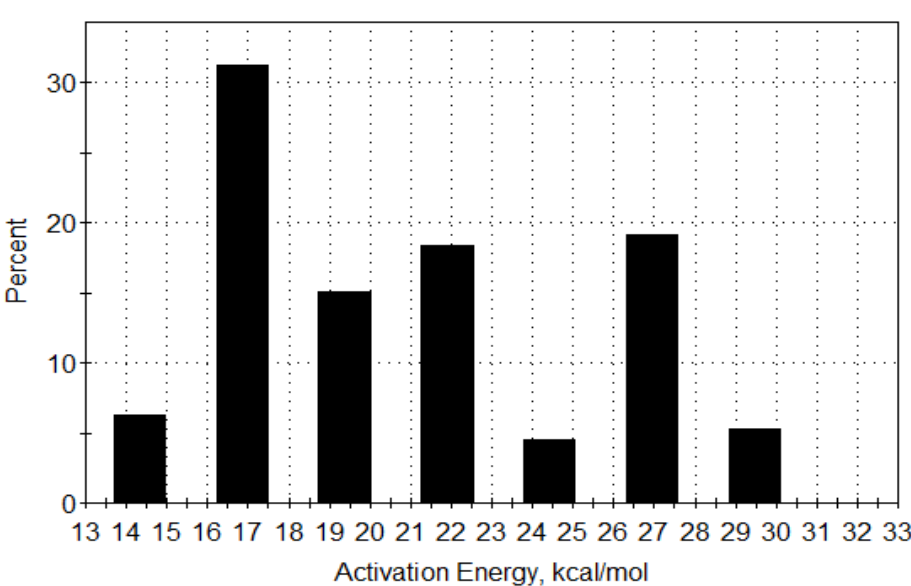
Figure 9. Distribution of activation energy for evaporation stage of FT thermal decomposition process .